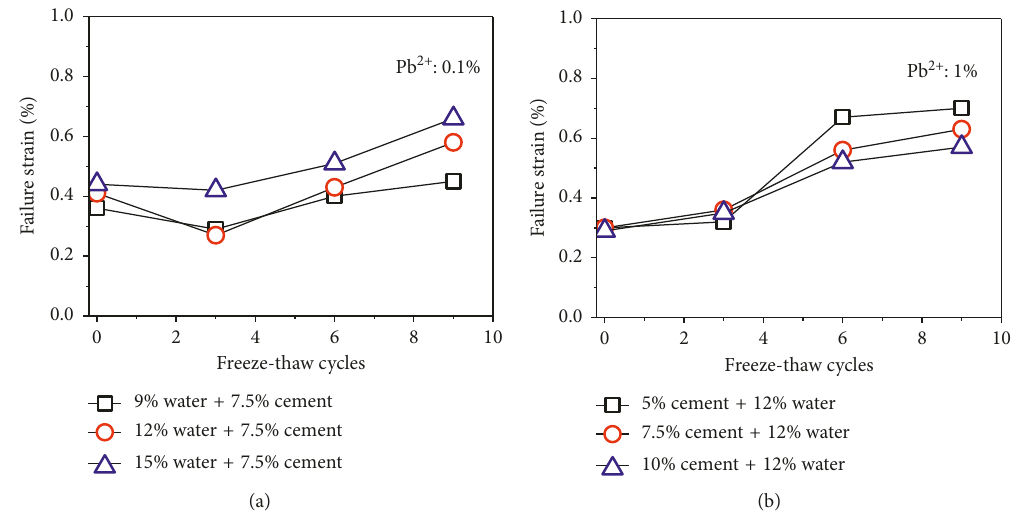
Figure 3: Failure strain of unreinforced soil samples during freeze-thaw cycles. (a) Various percentages of water content based on 7.5% cement+0.1% Pb(II). (b) Various percentages of cement content based on 12% water+1%